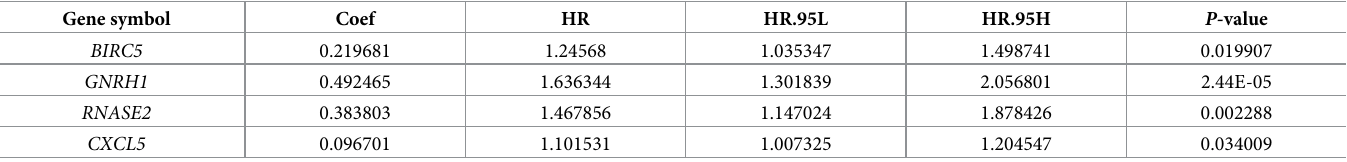
Fig 3. LASSO regression and univariate Cox regression. A Forest plot consists of 21 IRGs. (B-C) LASSO regression model. https://doi.org/10.1371/journal.pone.0272542.g003 Table 2. Multivariate Cox regression analysis revealed four prognostic markers